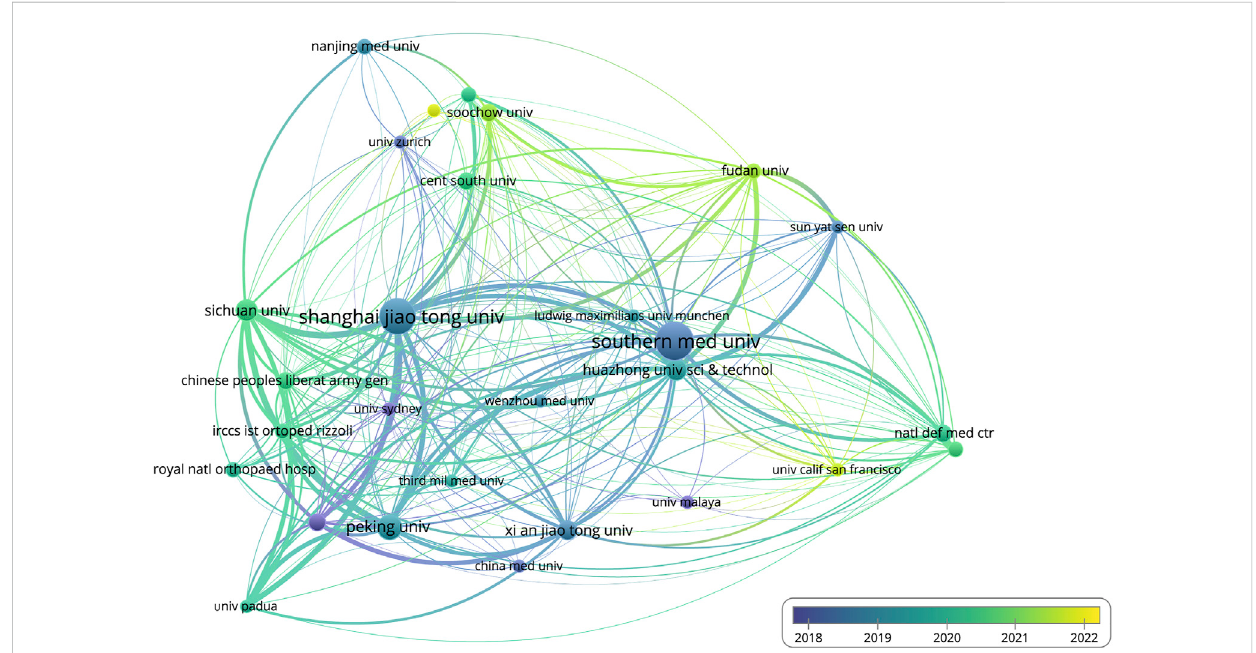
FIGURE 3 Visualization of institutional cooperation and publication period. (The size of the bubble represents the amount of paper issued by the institutions. The larger the bubble, the more paper is issued. In terms of time, the brighter the bubbles, the more recent research the organization has completed. Furthermore, the more connections there are between different bubbles, the closer the collaboration between different institutions will become.).